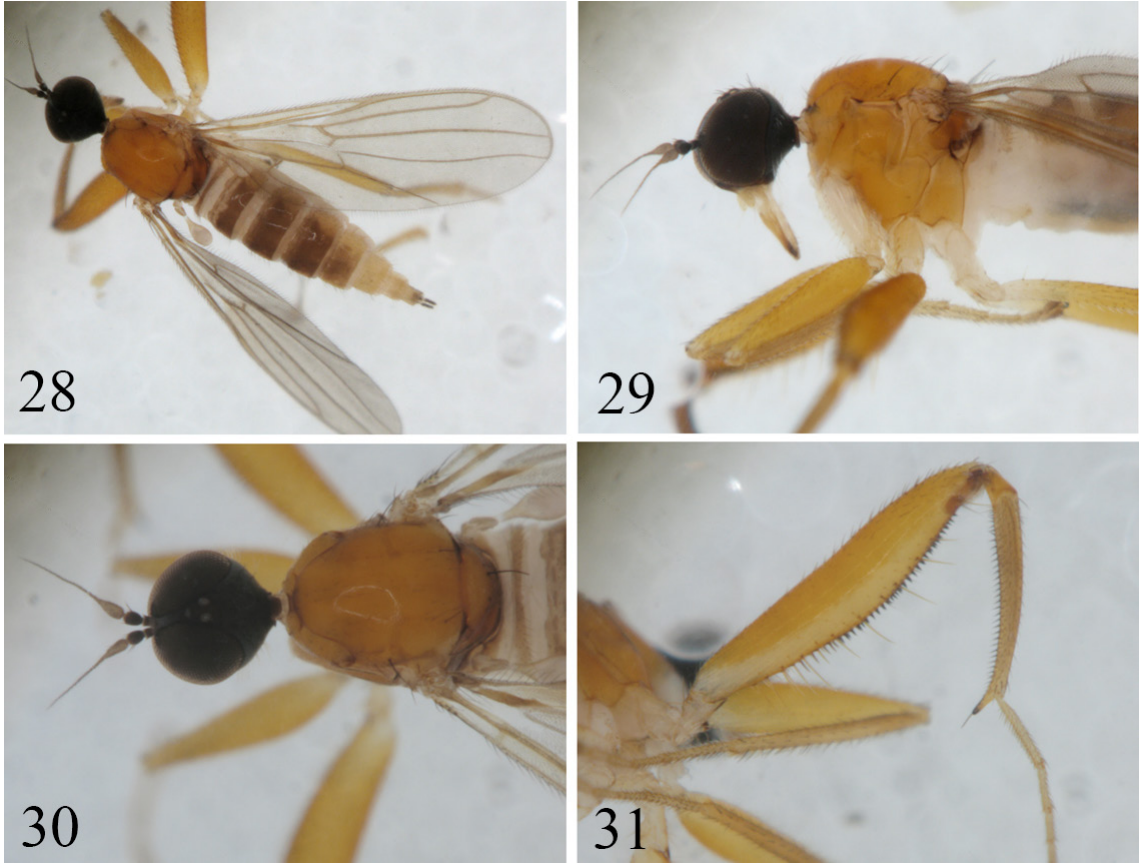
Figs 28–31. Platypalpus saffradi sp. nov., holotype ♀. 28 . Habitus, dorsal view. 29 . Head and thorax, lateral view. 30 . Head and thorax, dorsal view. 31 . Mid leg, anterior